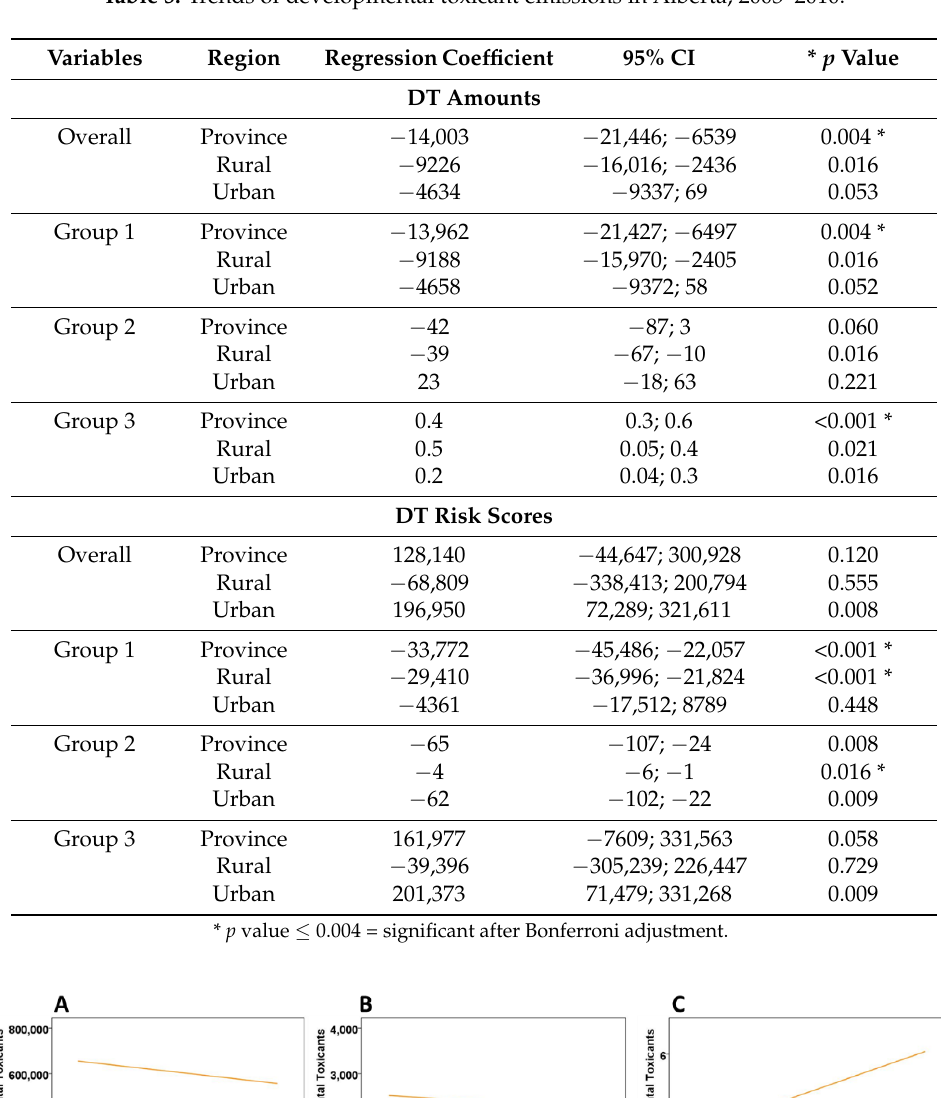
Table 5. Trends of developmental toxicant emissions in Alberta, 2003–2010.